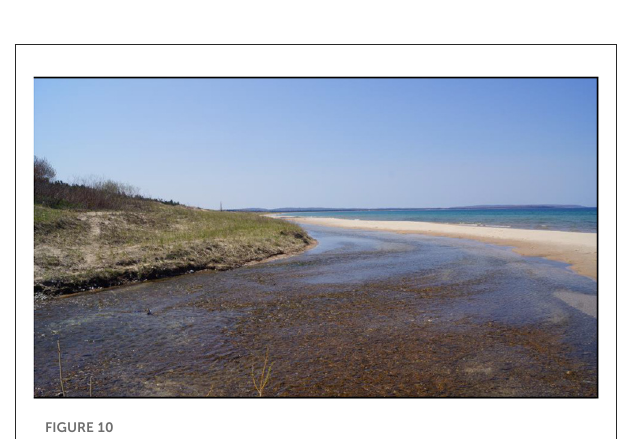
FIGURE10 Lake Michigan and otter creek mouth,